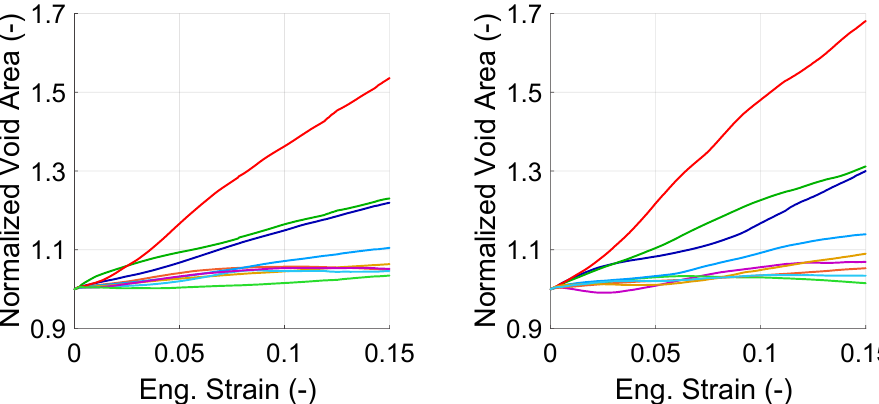
Figure 12. Evolution of the normalized area (with respect to initial area) of individual interface voids in banded ( left ) and random ( right ) morphology with total strain. Each color represents one